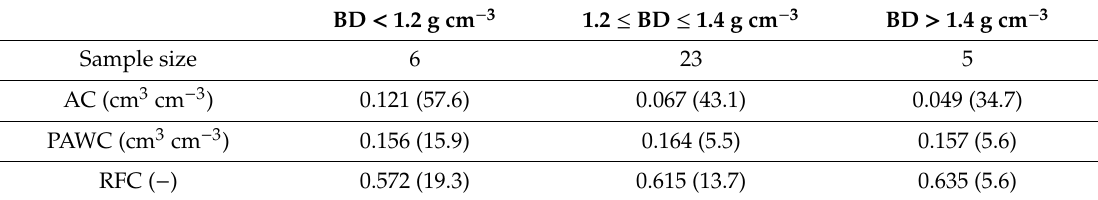
Table 3. Mean and associated coe ffi cient of variation (in brackets) of air capacity (AC), plant available water capacity (PAWC), and relative field capacity (RFC) obtained for the three soil bulk density classes.